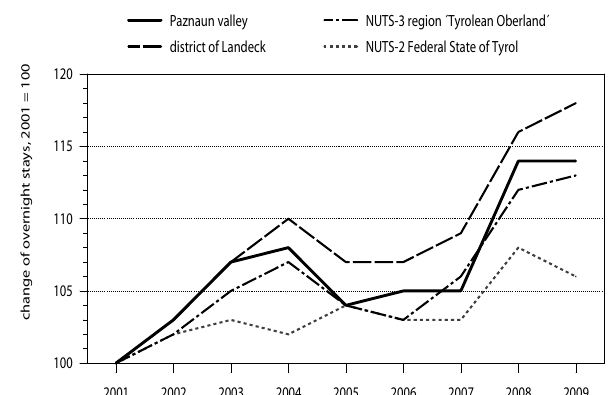
Fig. 8. Companies’ estimates of economic sectors that benefited from the 2005 flood event, multiple responses, n = 238. Fig. 9. Overnight stays in the study regions at different levels of ag- gregation for the touristic year (01/11 to 31/10) from 2001 to 2009; source: Statistics